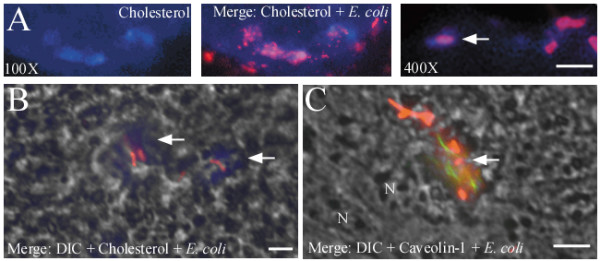
C. jejuni 81–176 causes accumulation of cholesterol and promotes co-localization of E. coli HB101 with lipid rafts. Epifluorescent images demonstrating (A) accumulation of cholesterol (blue), and co-localization of E. coli (orange-red) with (A, B) cholesterol and (C) caveolin-1 (green), 4 h post-infection. DIC, differential interference contrast. N, nucleus. Arrows indicate co-localization of E. coli with lipid raft markers. Bar = 2 μM. Representative images are shown from two experiments performed in quadruplicate.